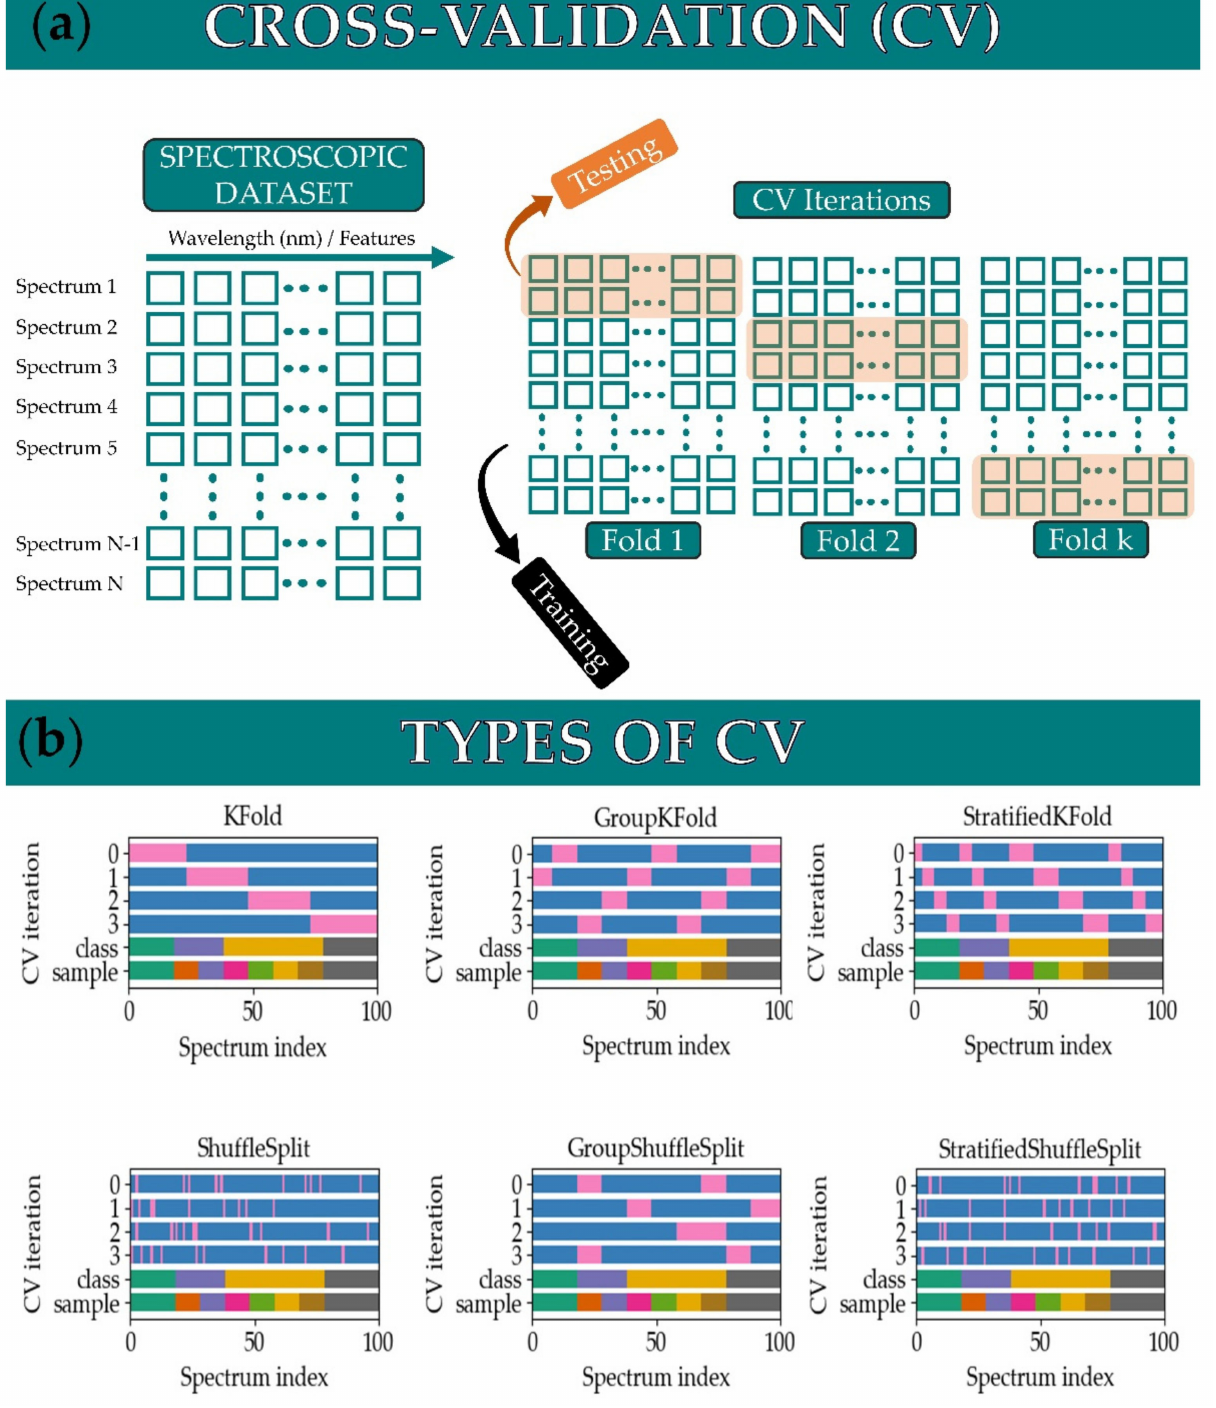
Figure 3. ( a ) Schematic of cross-validation. ( b ) Types of cross-validation (Adapted from ref.